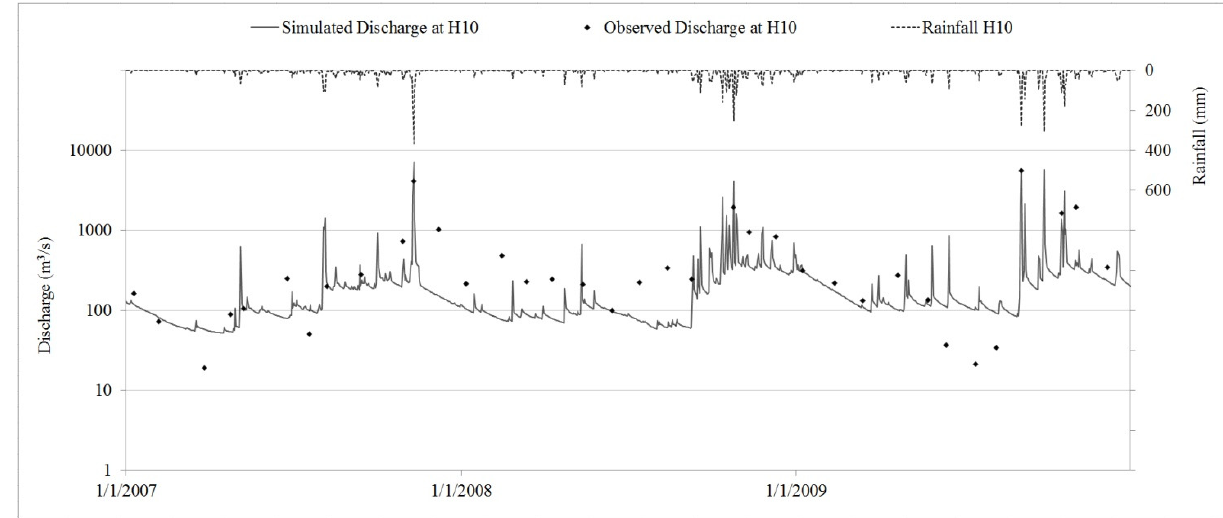
Figure 4. Discharge validation at H10.